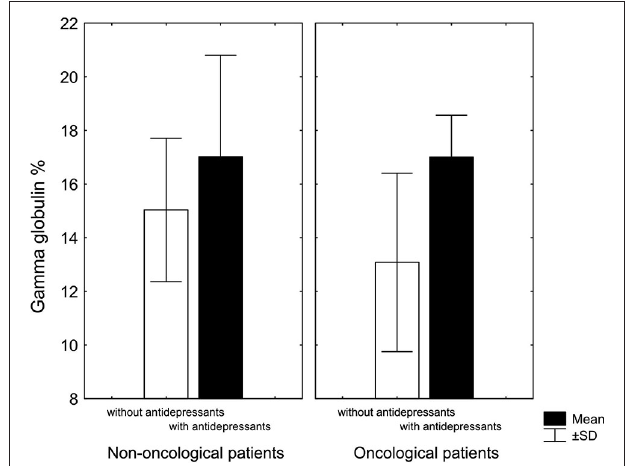
FIGURE 2 | Gamma globulin levels in patients with chronic nonmalignant and malignant pain associated with antidepressant treatment . In both groups, patients treated with antidepressants had higher levels of gamma globulin: in non-oncological patients only marginally ( KW-H ( 1,20 ) = 2.7, p = 0.09), in oncological patients significantly higher ( KW-H ( 1,18 ) = 7.0, p = 0.008) (Adopted from Rokyta et al.,